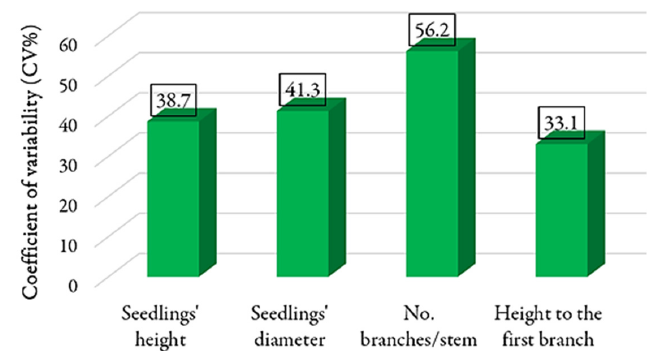
Figure 8. Coefficient of variability (CV%) for the main growth elements of R. pseudoacacia seedlings